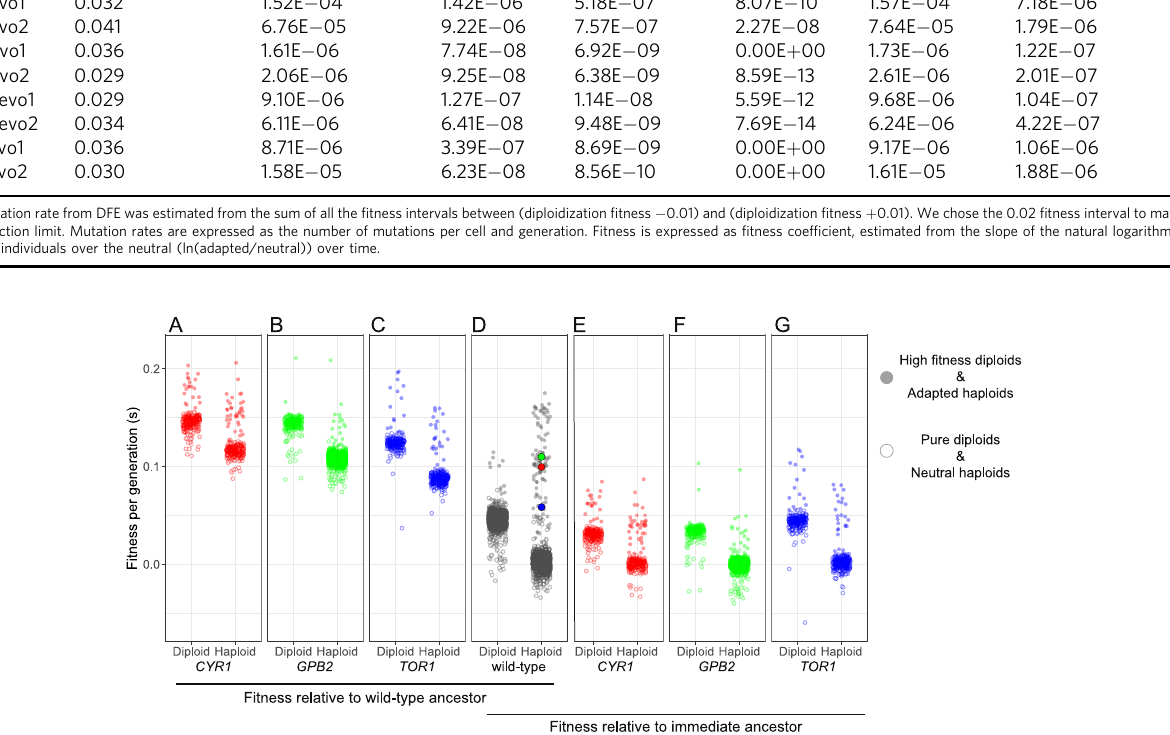
Table 2 Mutation rates per genotype and diploidization fi tness calculated from the DFE shown in Fig. 2. Genotype, Diploidization fi tness (1st peak at evolution mutation spectrum, Fig. 2)